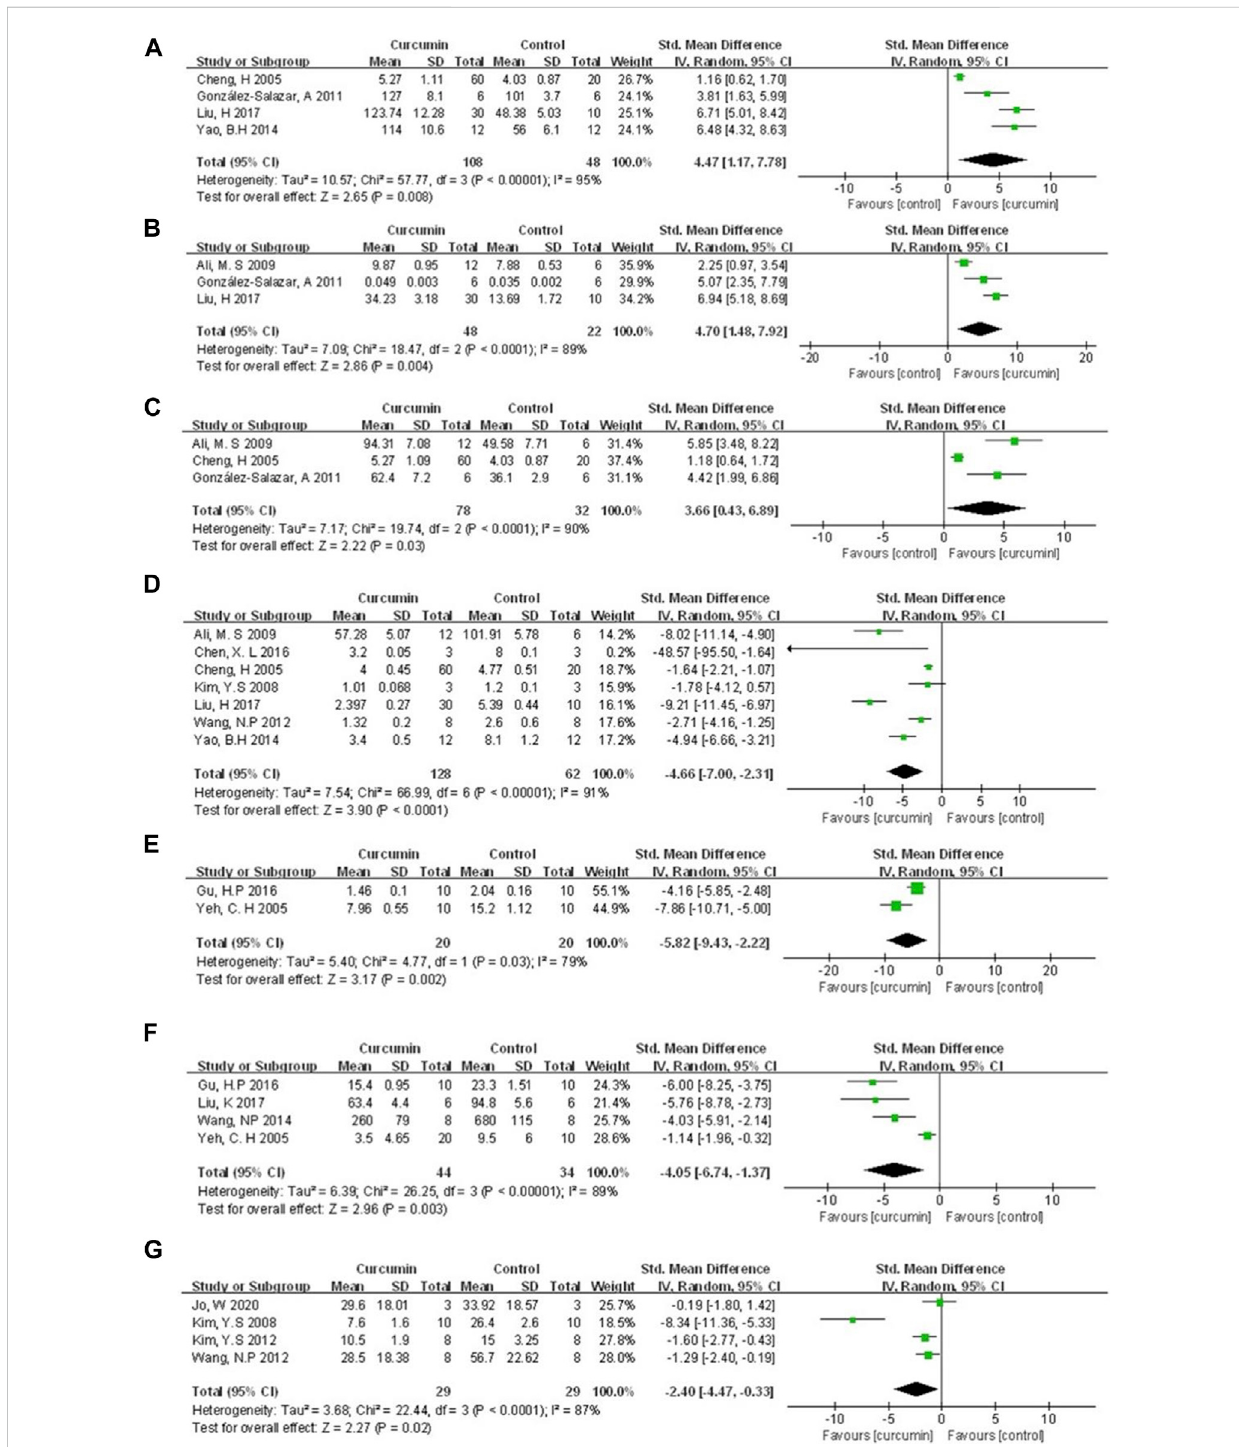
The meta-analysis results of the effect of curcumin on (A) SOD (B) CAT (C) GSH (D) MDA (E) NF- κ B protein (F) TNF- α protein, and (G)